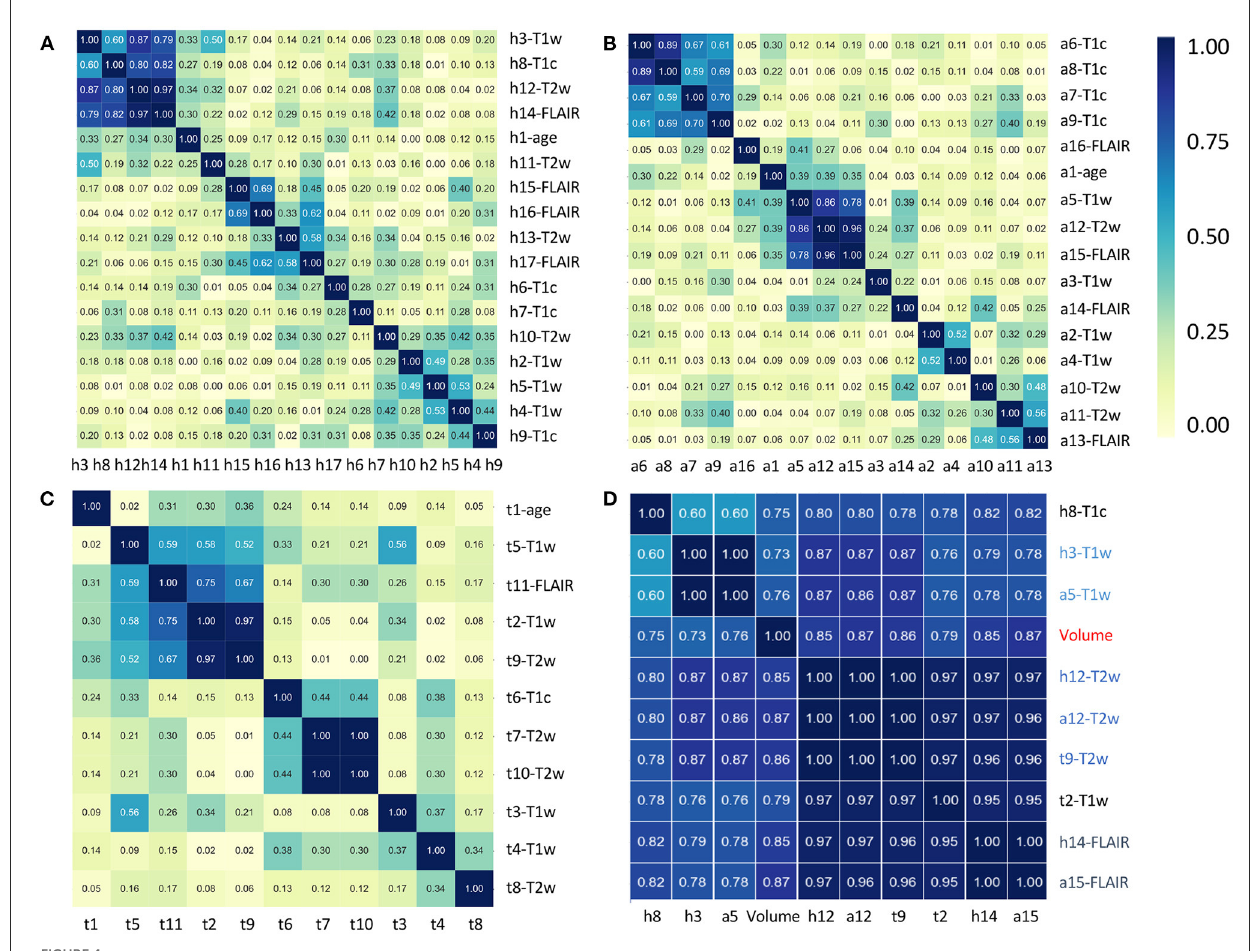
predicting H3.1 mutation (0.91 vs. 0.92 for M T 1 c ). Sensitivity